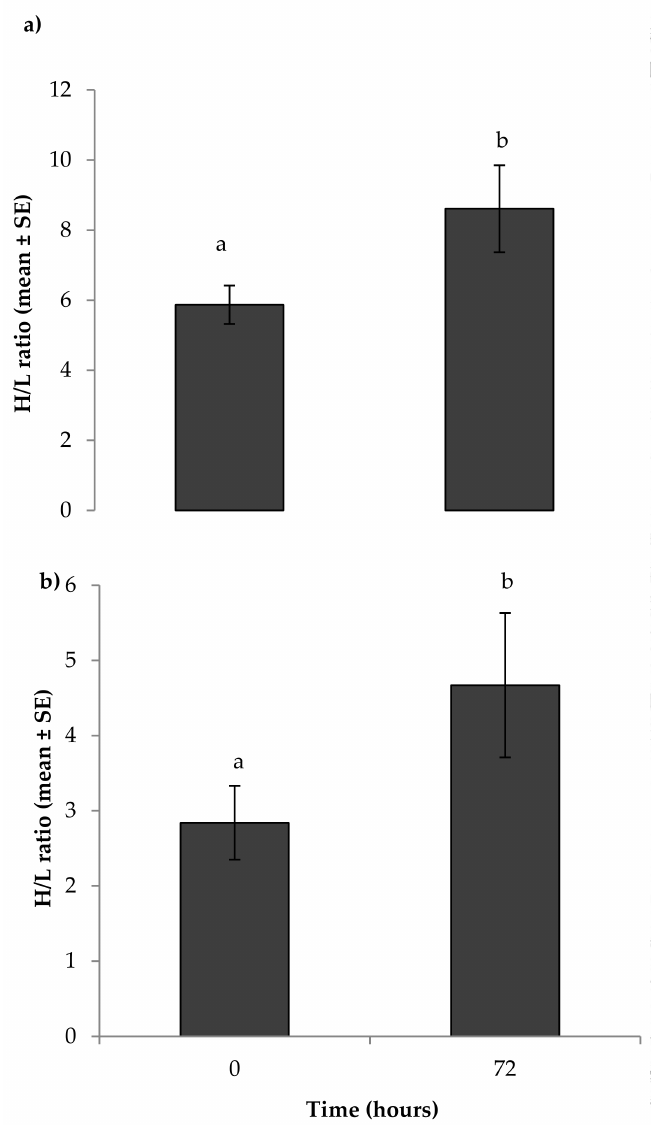
Figure 3. Mean heterophil/lymphocyte (H/L) ratios as a measure of acute stress responses of 7.5 months old ostriches before and 72 h after: ( a ) feather harvesting ( N = 238); ( b ) feather clipping ( N = 87). Means with different superscripts differed significantly ( p <